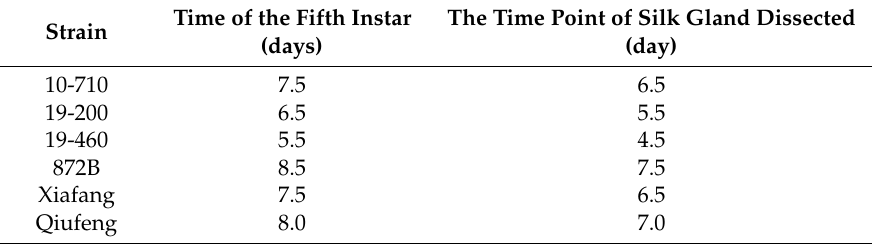
Figure 2. Boxplot of the log transformed RPKM expression values of six silkworm strains. RPKM: Reads per kilobases per million reads. The solid horizontal line represents the median, and the box encompasses the lower and upper quartiles. Table 2. Dissection time points of different